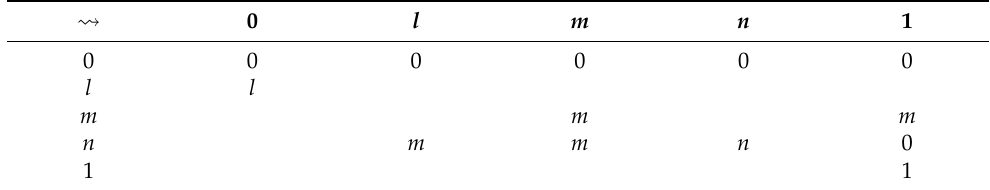
Table 19. The partial operation (cid:32)